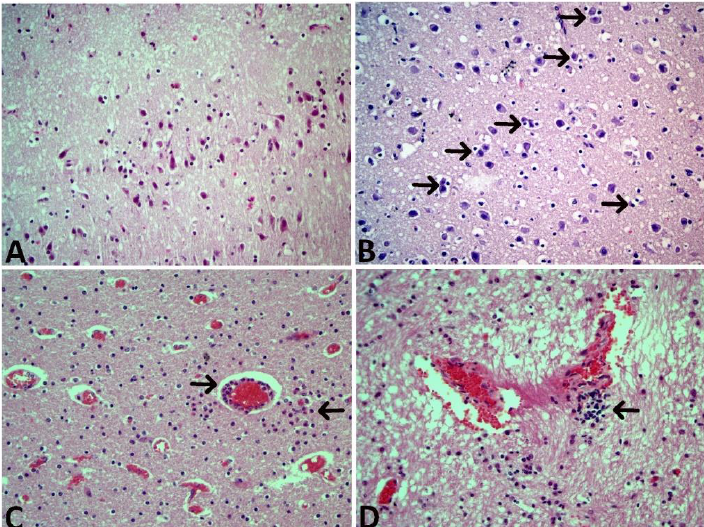
Figure 3. Microscopic photographs ( A ) Edema and hemorrhage in the meninges (arrows), HE, 10X, ( B ) Hyperemia (black arrow) in the meningeal veins and edema in the submeningeal region (blue arrows), HE, 10X, ( C ) Hemorrhage spreading to the neuropil tissue (arrows), HE, 20X, ( D ) Severe hyperemia and vasodilation, HE, 10X.